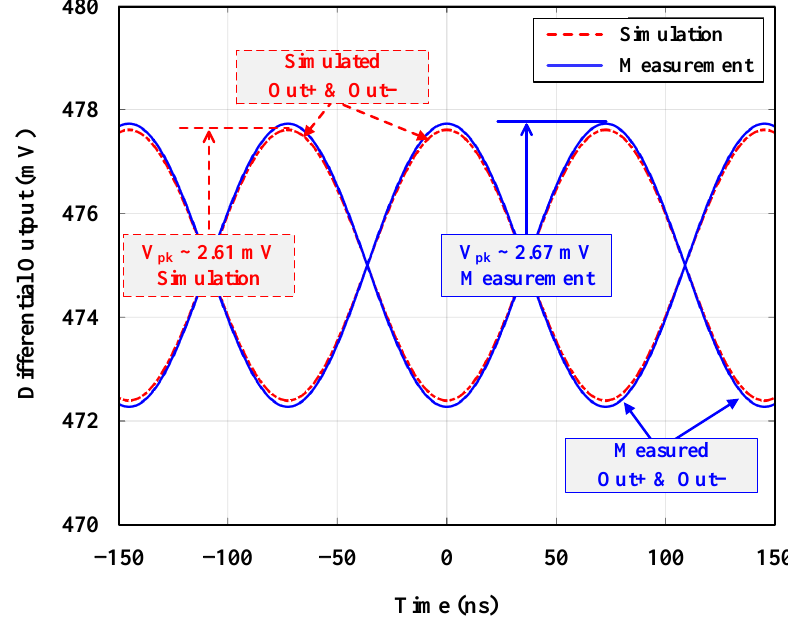
Figure 11. TIA differential output transient response, both measured and